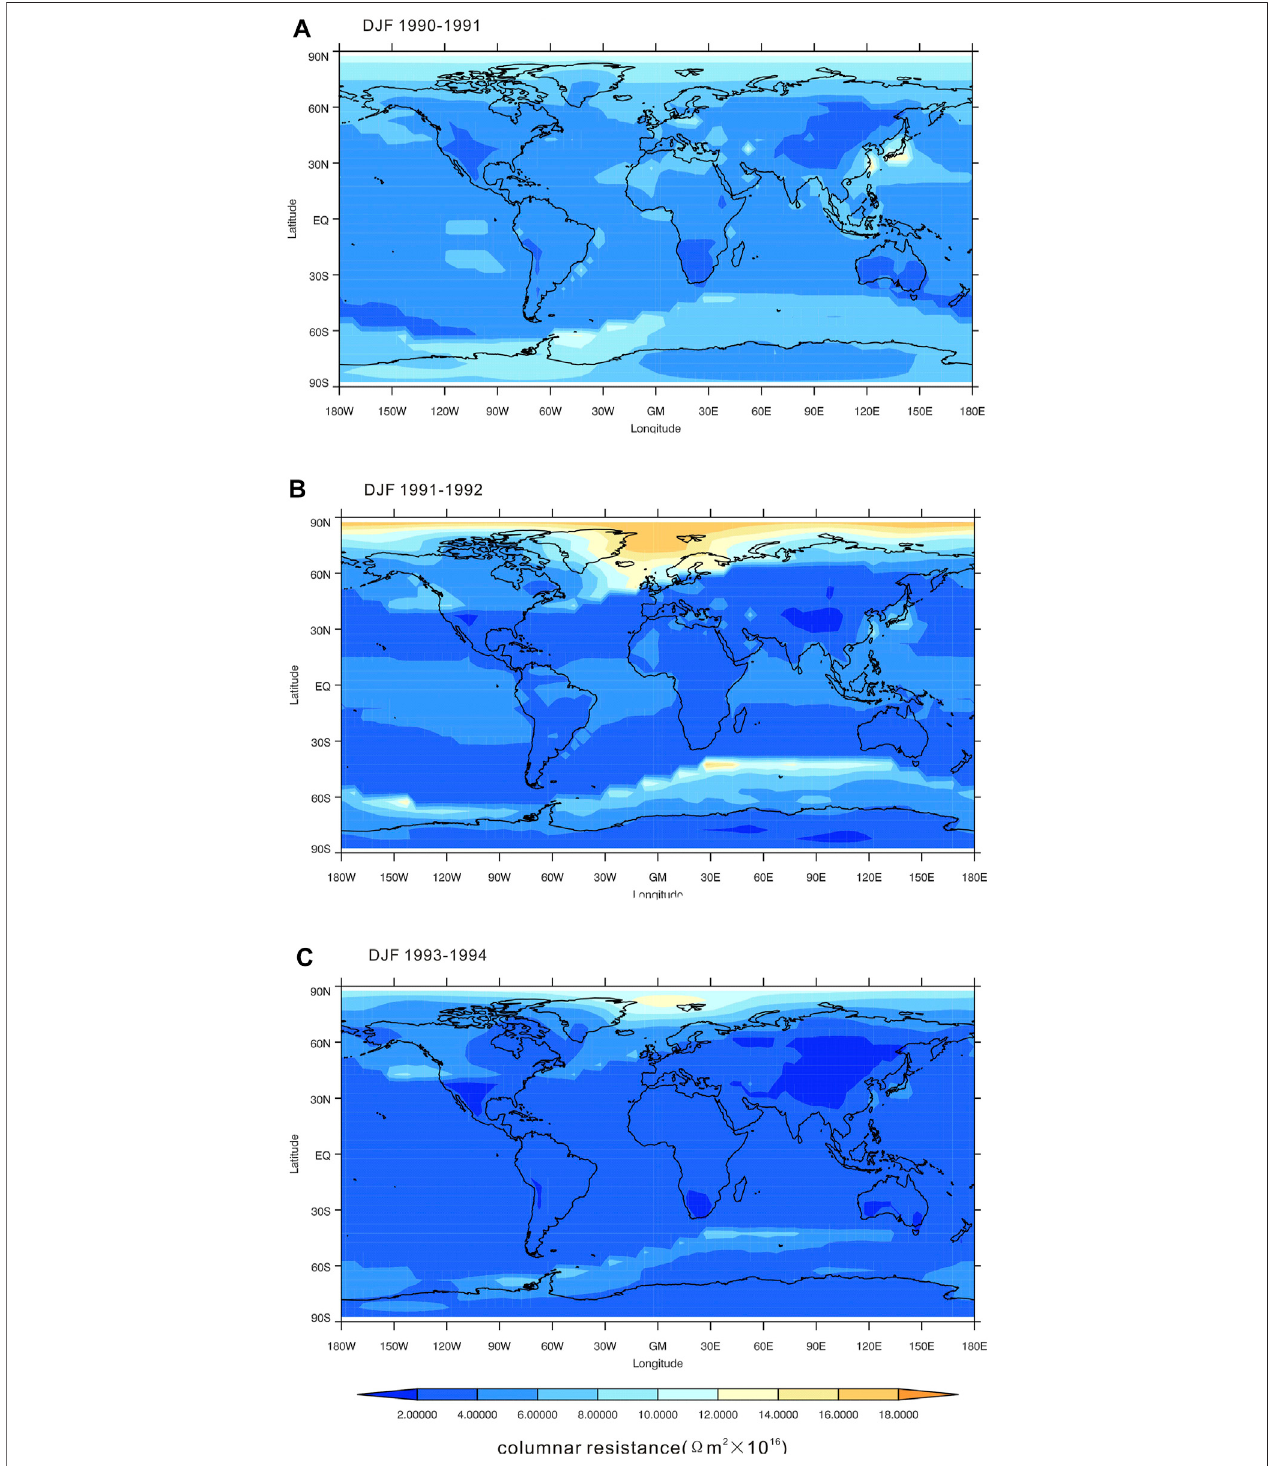
FIGURE 8 | The gridded global column resistance in DJF (A) 1990 – 1991, (B) 1991 – 1992, and (C) 1993 – 1994.